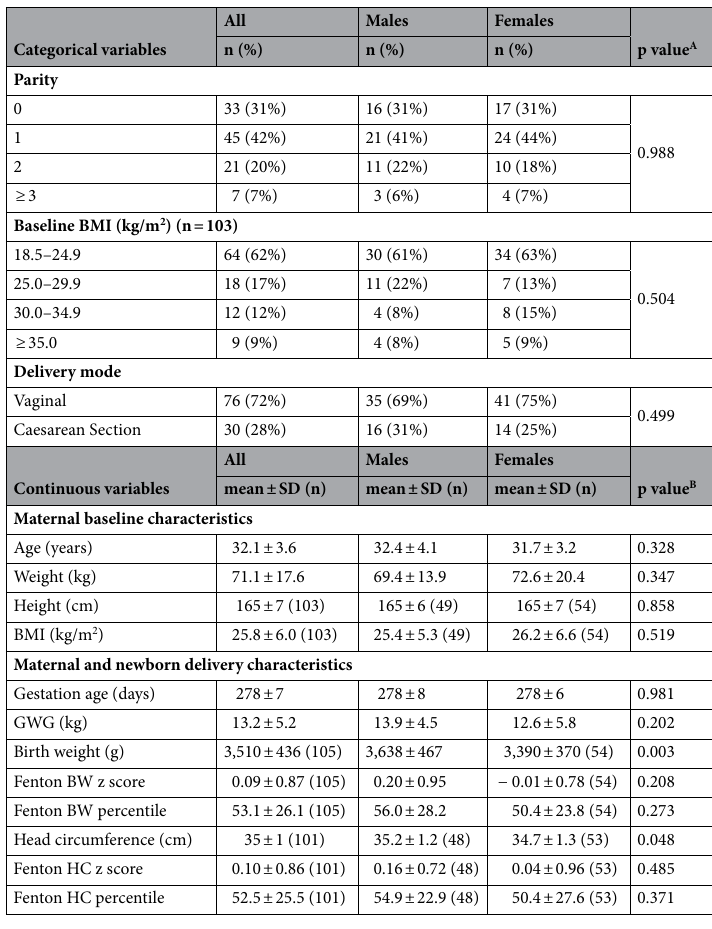
Table 1. Characteristics of the study populations among 106 MMIP participants, stratified by sex. Values are n (%) or mean ± SD. Stratified by males (n = 51) and females (n = 55). A Represents Pearson’s chi-square test for categorical variables. B Represents unpaired t test for continuous variables. If sample size differs, mean ± SD